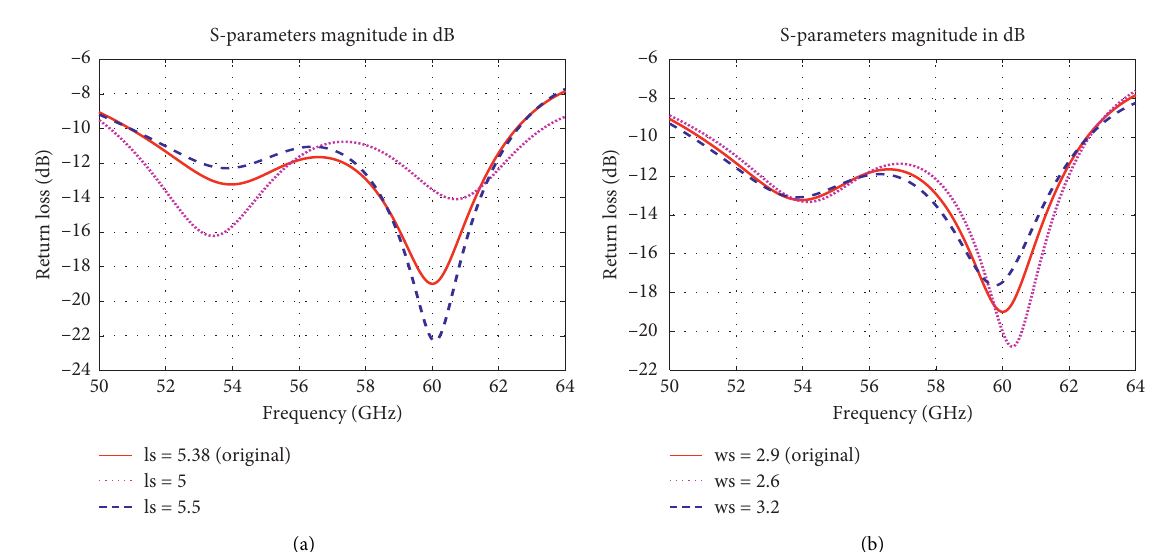
Figure 9: Return loss for change in radiator dimension. (a) “ls.” (b)